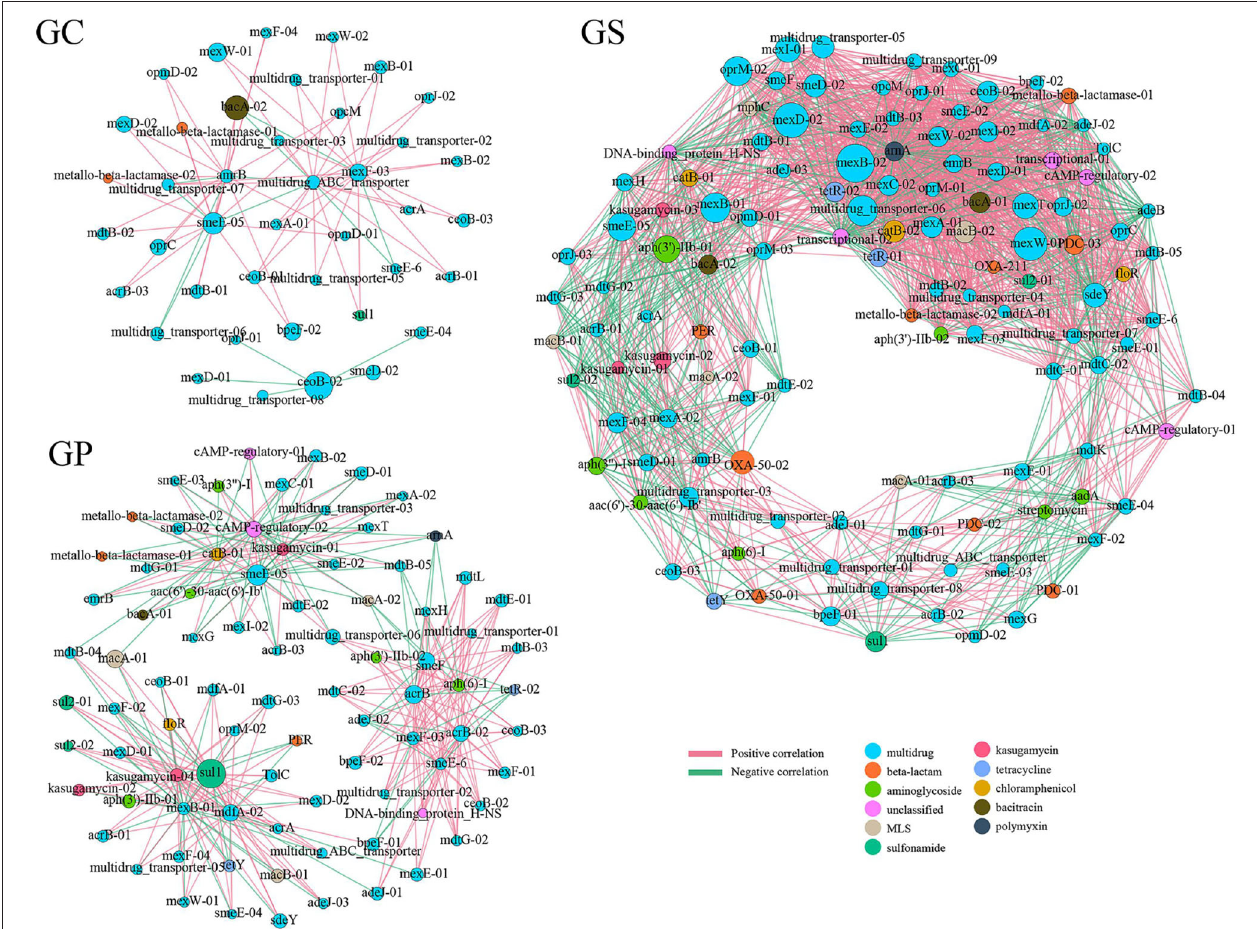
FIGURE 4 | The network analysis revealing the co-occurrence patterns among ARG subtypes in GC, GS, and GP. The nodes were colored according to ARG types. A connection represents a strong (Spearman’s correlation coefficient r > 0.90) and significant ( p ≤ 0.001) correlation. Edges and node size weighted were based on the correlation coefficient and the relative abundance of ARGs,